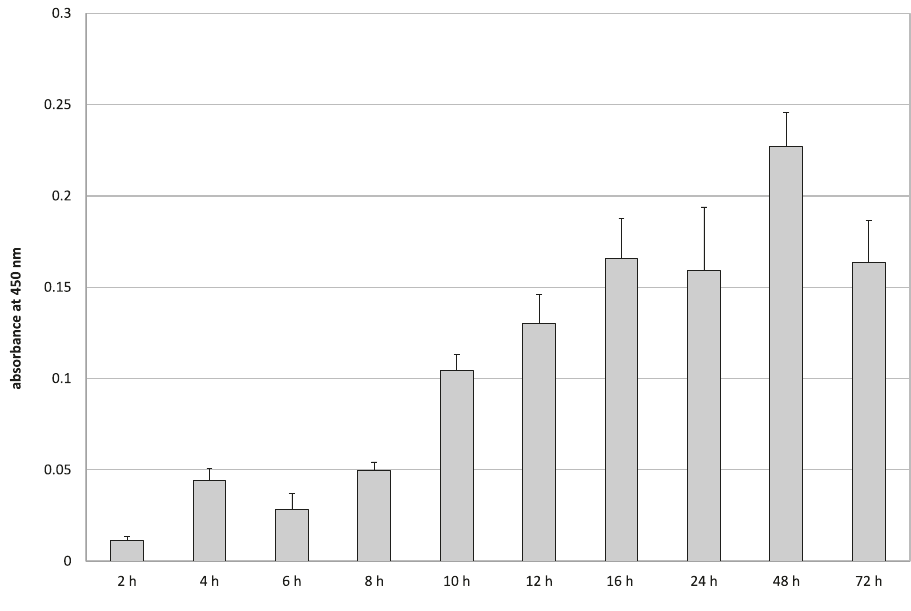
Fig. 1 Adherence of P. fl uorescens to the borosilicate glass substrate was determined after a 15 min, b 30 min, c 60 min, d 90 min, and e 120 min incubation in LBM 1:100 diluted in 0.9% NaCl. Samples